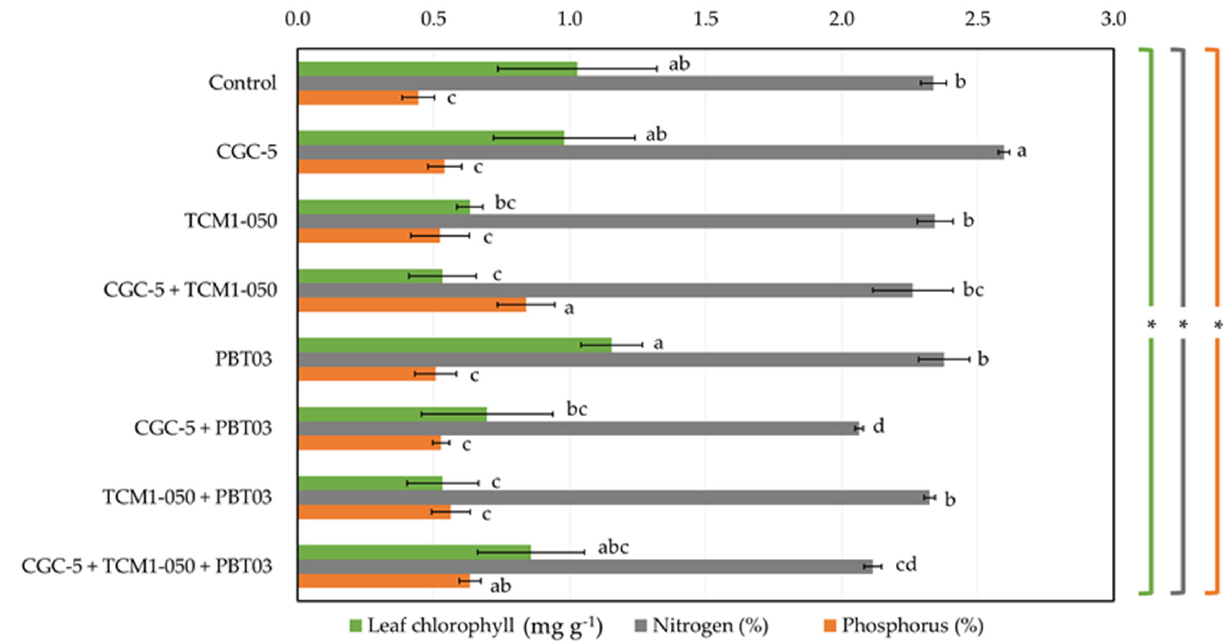
Figure 5. Impacts of teak rhizosphere microbes on teak leaf phytochemicals. Different treatments were established, including a non-inoculated control and those inoculated with Agrobacterium sp. CGC-5, Kitasatospora sp. TCM1-050, Claroideoglomus sp. PBT03, or different consortia of these microbes. The experiments were done in five replicates. Small case letters refer to the statistical difference of means compared by one-way ANOVA at α = 0.05. The statistical results comprise of chlorophyll ( F (7, 32) = 7.59, p ≤ 0.0005), nitrogen ( F (7, 32) = 16.57, p ≤ 0.0005), and phosphorus ( F (7, 32) = 7.98, p ≤ 0.0005) contents of teak leaves. The asterisk remark indicates the statistical significance.